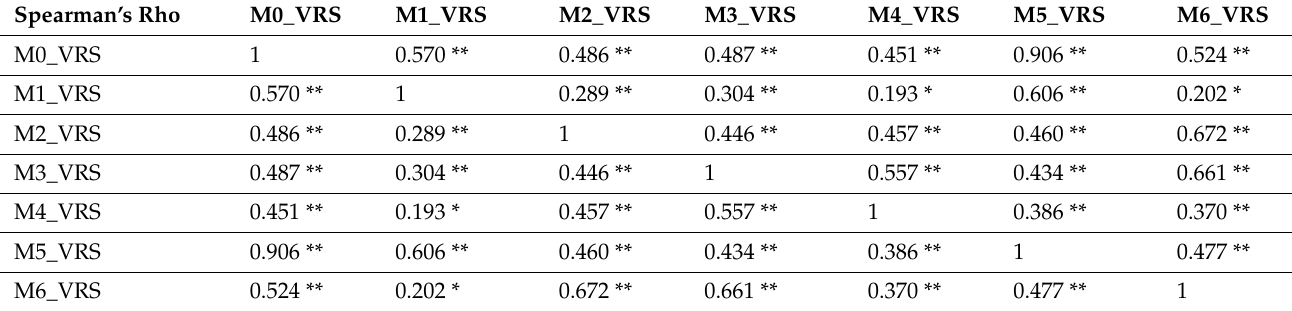
Table 10. Internal Validity check—Spearman-rank correlation